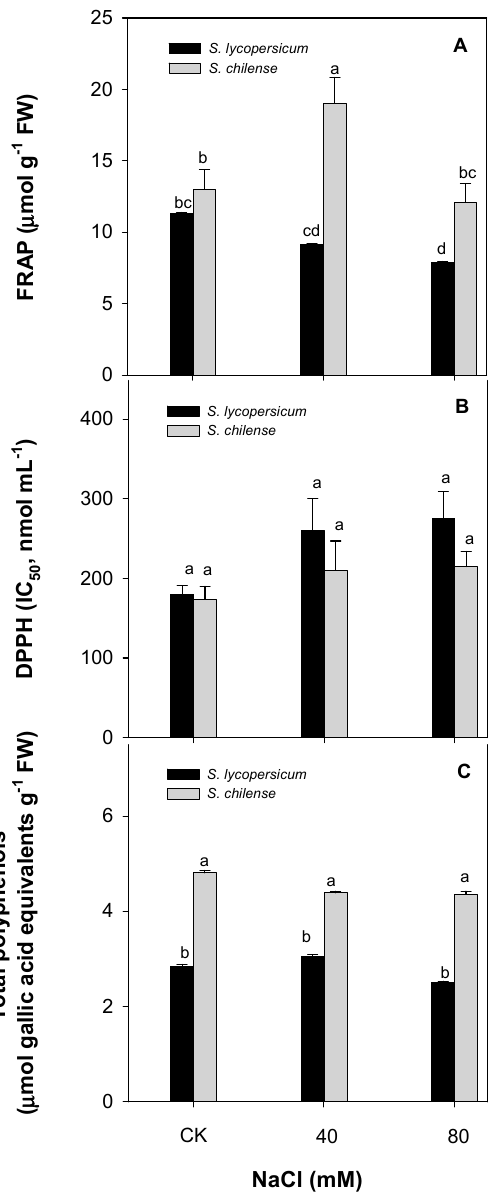
Figure 2. Fruit ferric reducing antioxidant power (FRAP) (µmol g − 1 FW; ( A )) and 2,2-diphenyl-1- picrylhydrazyl (DPPH) (nmol g − 1 FW; ( B )) indexes and fruit total polyphenol content (TP) (µmol gallic acid equivalents g − 1 FW; ( C )) in two species of tomato (domesticated Solanum lycopersicum and wild- relative S. chilense ) cultivated for 112 days in nutrient solution containing 0 (control treatment, CK), 40 or 80 mM NaCl. Each value represents the mean ± SE ( n = 6). Lower-case letters indicate differences ( p ≤ 0.05, Duncan test) between treatments and species.